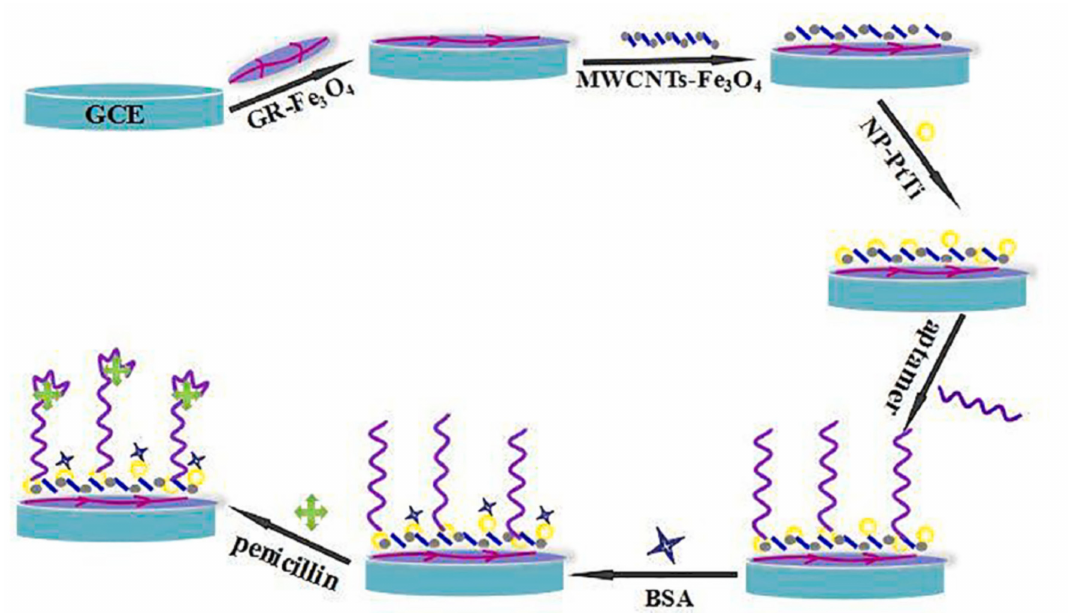
Figure 15. Schematic representation of a label-free aptasensor for the detection of penicillin based on nanoporous